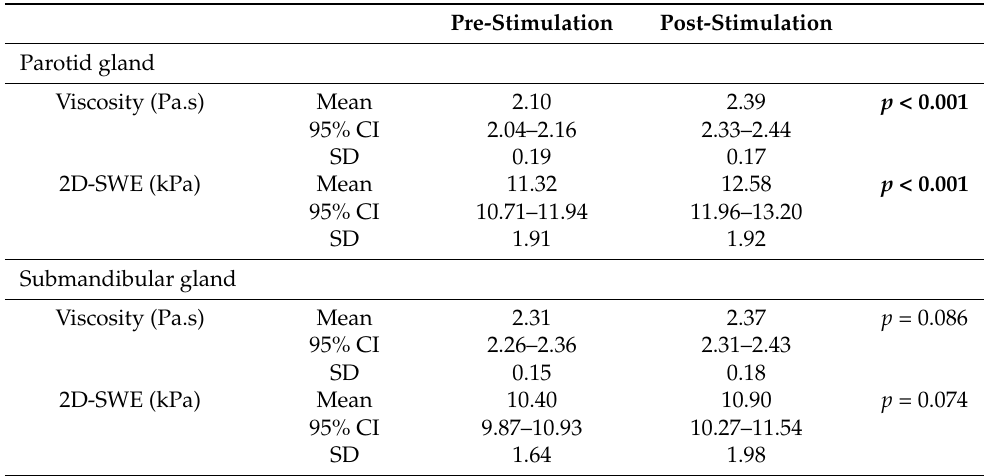
Table 2. Mean stiffness and viscosity values of the parotid and submandibular gland in a group of healthy subjects in a basal state and following